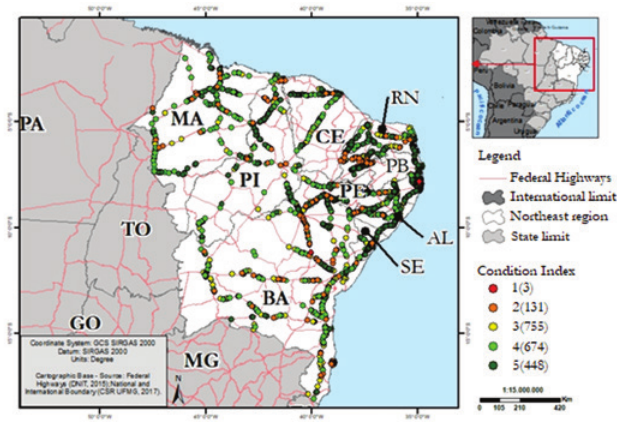
Geographic distribution of bridges inventory